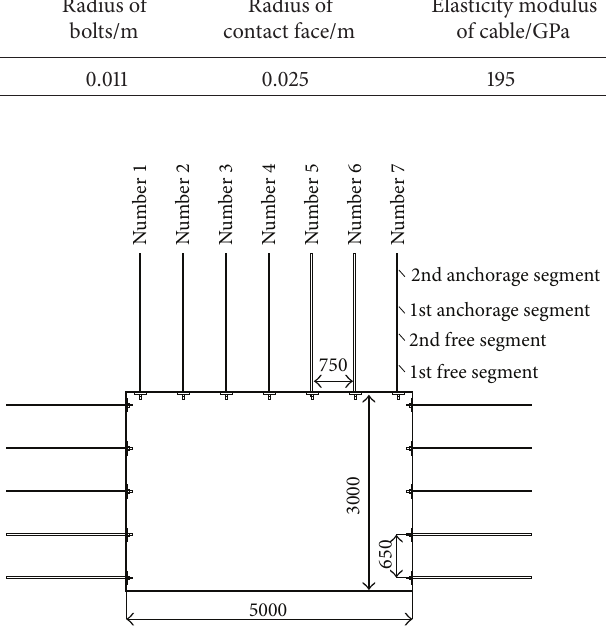
Figure 2: Arrangement and serial numbers of